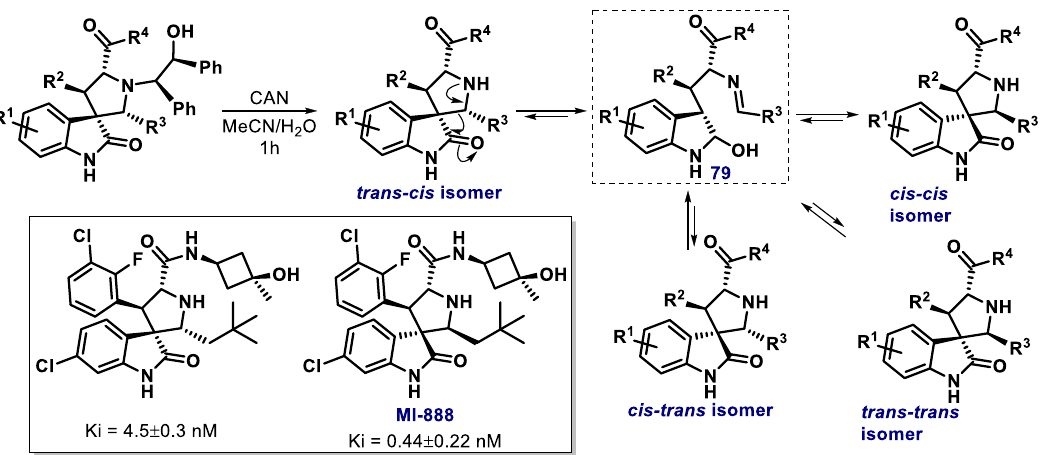
Scheme 20. Isomerization of MI-888-type compounds in the presence of a acetonitrile/water solvent system. CAN = ceric ammonium